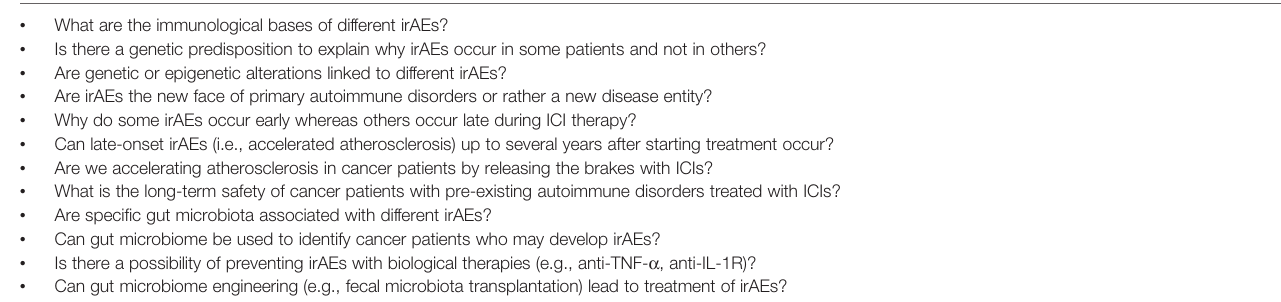
TABLE 4 | Outstanding pathophysiological and therapeutic questions relevant to immune-related adverse events (irAEs) associated with immune checkpoint inhibitors. (cid:129) What are the immunological bases of different irAEs? (cid:129) Is there a genetic predisposition to explain why irAEs occur in some patients and not in others? (cid:129) Are genetic or epigenetic alterations linked to different irAEs?